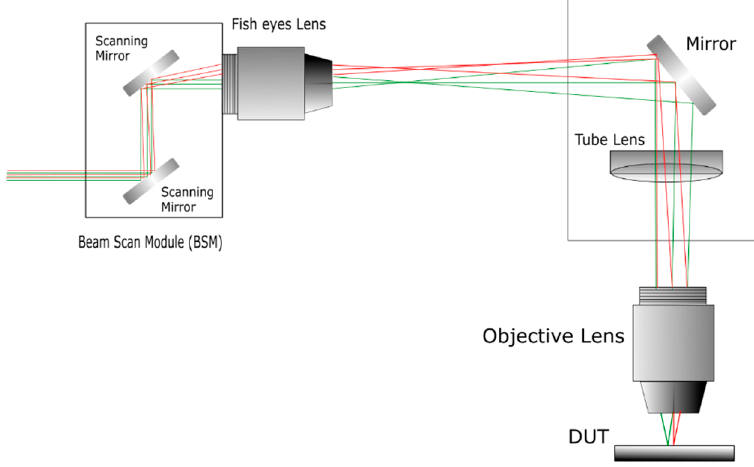
Figure 2. Schematic of mirror–mirror module.